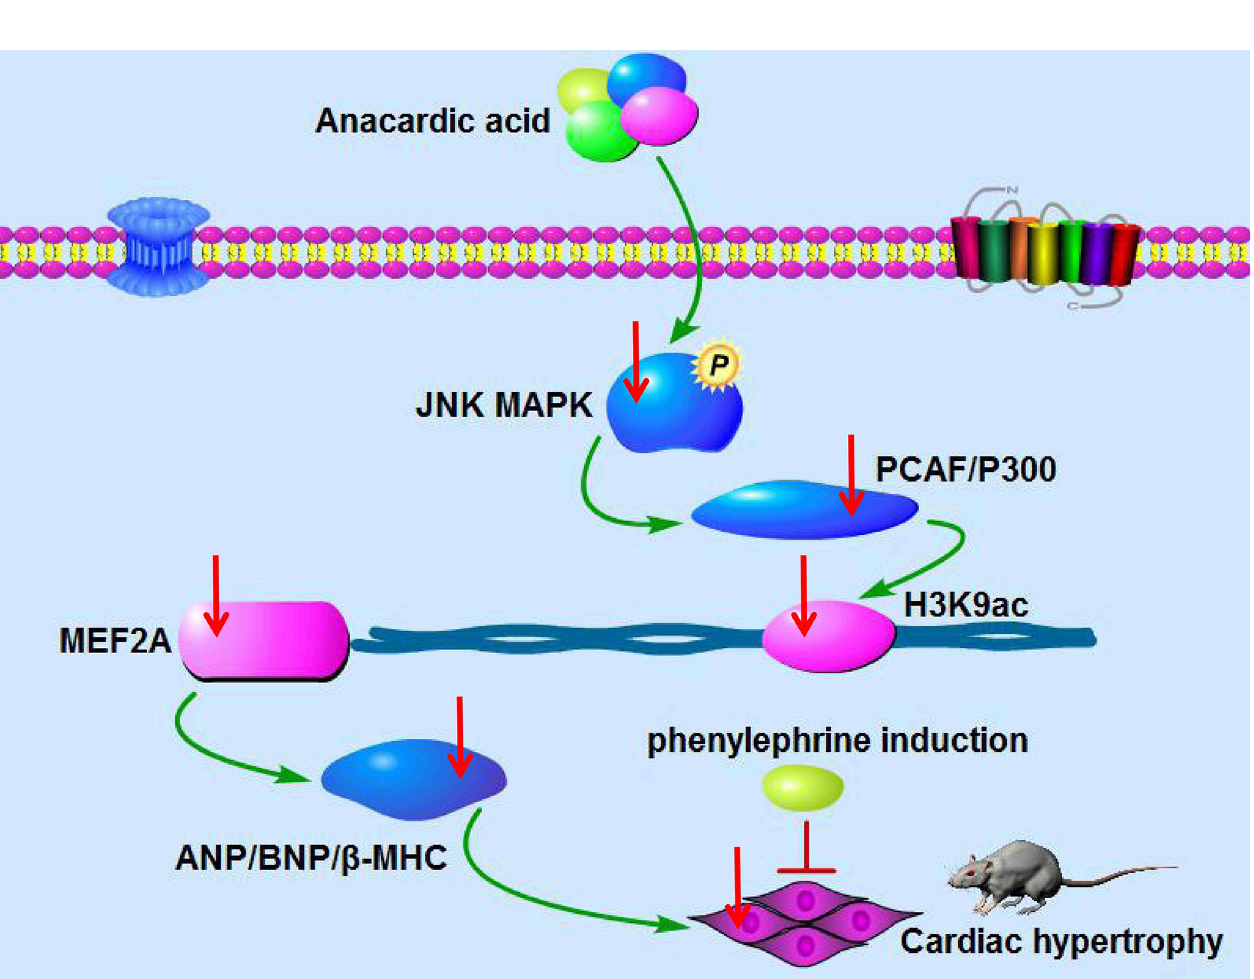
Fig 8. Schematic representation of the possible mechanism through which anacardic acid (AA) attenuates phenylephrine (PE)-induced cardiomyocyte hypertrophy. AA could ameliorate cardiac hypertrophy by regulating JNK signaling-induced histone H3K9ac acetylation. AA enters the myocardial cell, and acts on P300-HAT and PCAF-HAT via p-JNK pathway, and downregulates P300-HAT and PCAF-HAT expression. Subsequently, the binding of P300-HAT and PCAF-HAT to the promoter of MEF2A is reduced, which leads to histone H3K9ac hypoacetylation in the promoter of MEF2A and further inhibits MEF2A transcription level, and finally downregulates cardiac hypertrophy-related genes ANP, BNP, and β -MHC overexpression induced by PE to prevent cardiac hypertrophy.